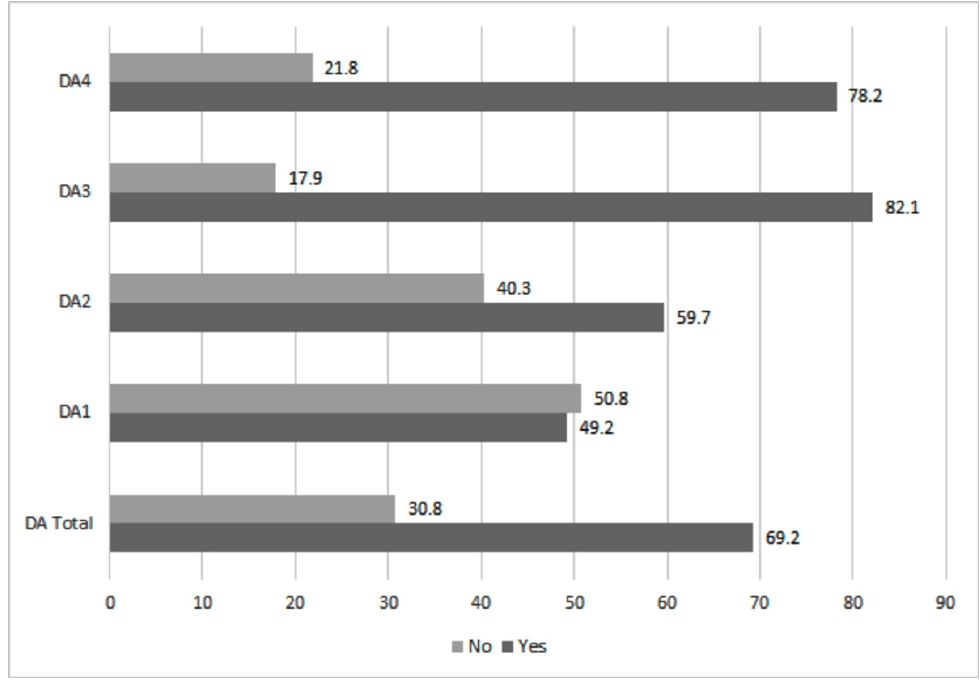
Figure 1. General index of DA and its subscales, in